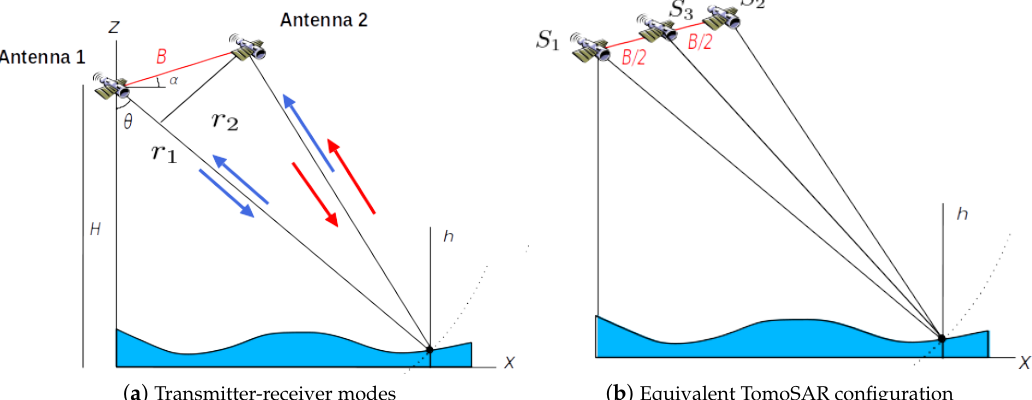
Figure 3. Illustration of transmit–receive modes and equivalent dual-baseline TomoSAR configuration. S 1 and S 2 are the real positions of Antenna 1 and Antenna 2, whereas S 3 is the virtual resulting